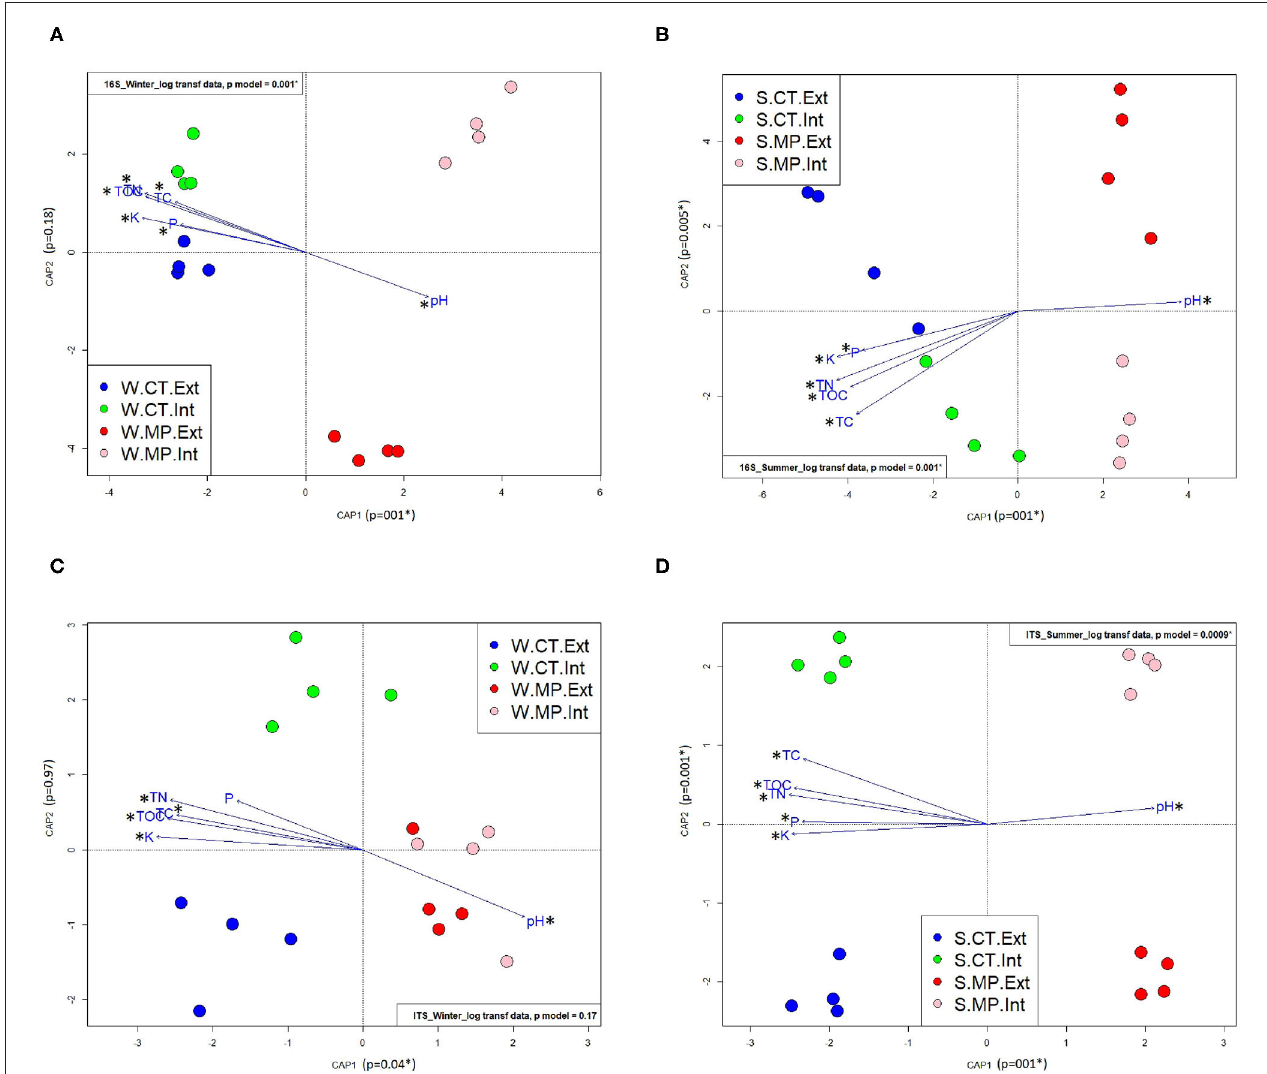
FIGURE 2 | Constrained analysis of principal coordinates (CAP) using Bray–Curtis distance of bacterial/archaeal (A,B) and fungal (C,D) communities in soils sampled in LTE Bernburg in winter (W) or summer (S) under different long-term tillage practices (CT, Cultivator Tillage vs. MP, Moldboard Plow) and N-fertilization intensities (Int, intensive vs. Ext, extensive). Asterisks indicate a significant correlation of the chemical parameter with the community composition ( p < 0.05). Soil chemical parameters: total nitrogen (TN), total carbon (TC), total organic carbon (TOC), available potassium (K), and phosphorus (P) content and